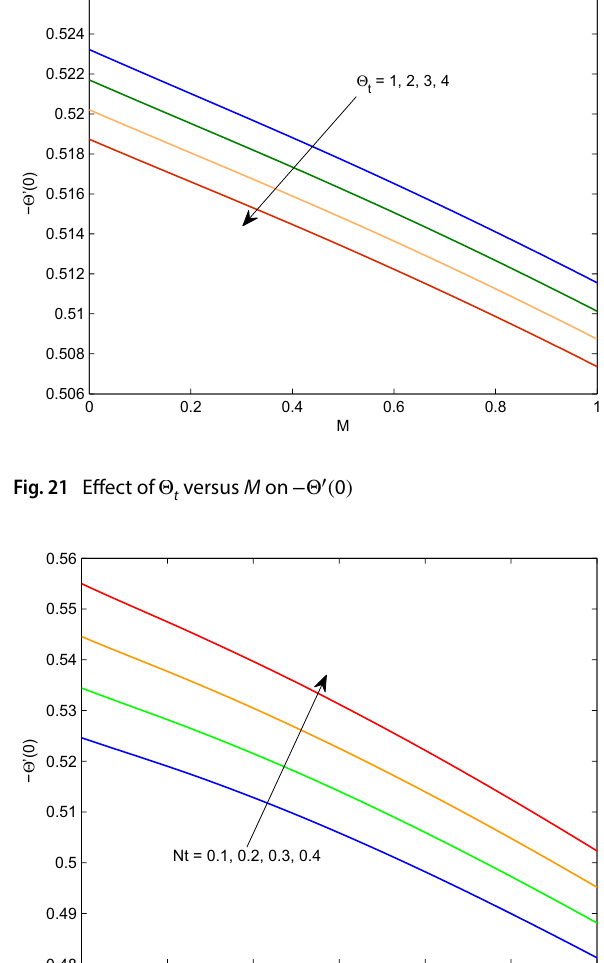
Fig. 19 Φ( 𝜁 ) against Bi